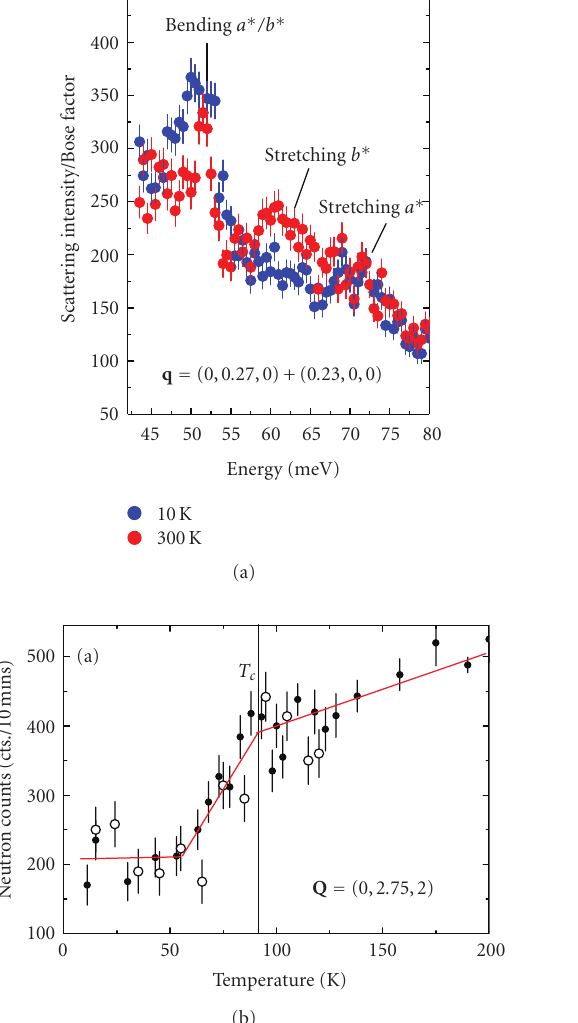
Figure 23: Data of [74] for the (cid:2) 4 symmetry in YBa 2 Cu 3 O 6 . 95 . (a) Comparion of the 300 K and 10 K spectra. (b) Backround- subtracted intensity at Q = (0,2 . 75,2) and E = 60meV (see text). Open and solid circles represent di ff erent datasets from [74].